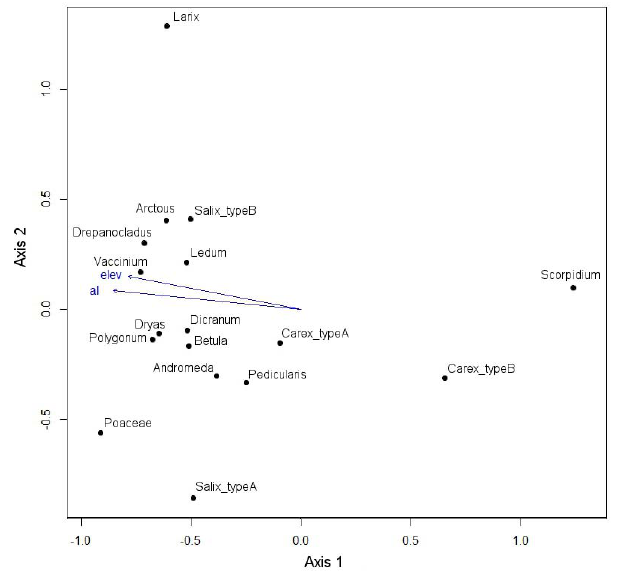
Fig. 4. NMDS plot for the surface vegetation from the 07-SA-LY polygon.